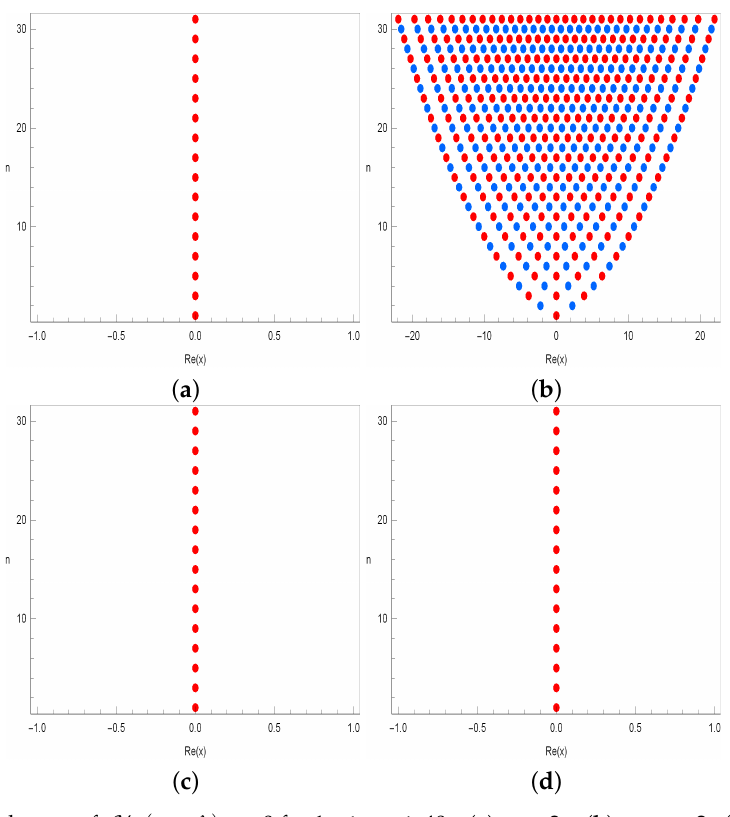
Figure 4. Real zeros of H n ( x , y , λ ) = 0 for 1 ≤ n ≤ 40. ( a ) y = 2 ; ( b ) y = − 2; ( c ) y = 2 + i ; ( d ) y = − 2 − i .